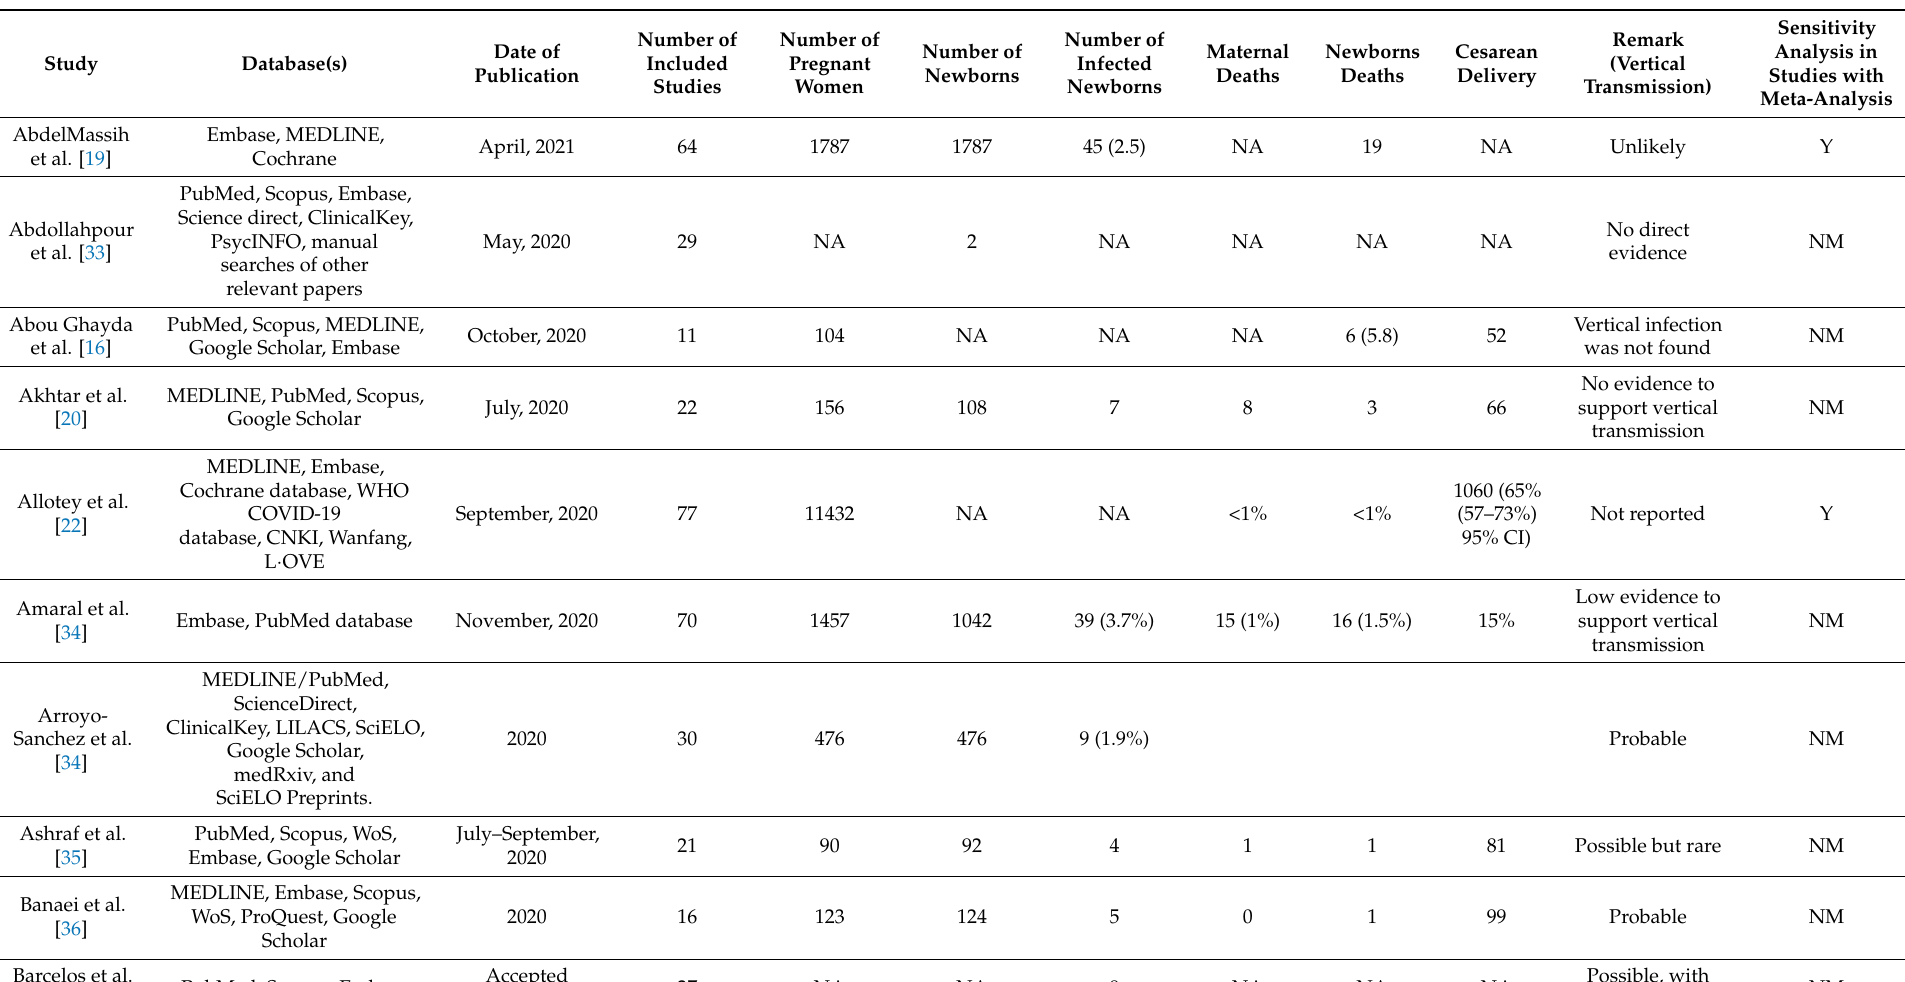
Table 1. Features of the included